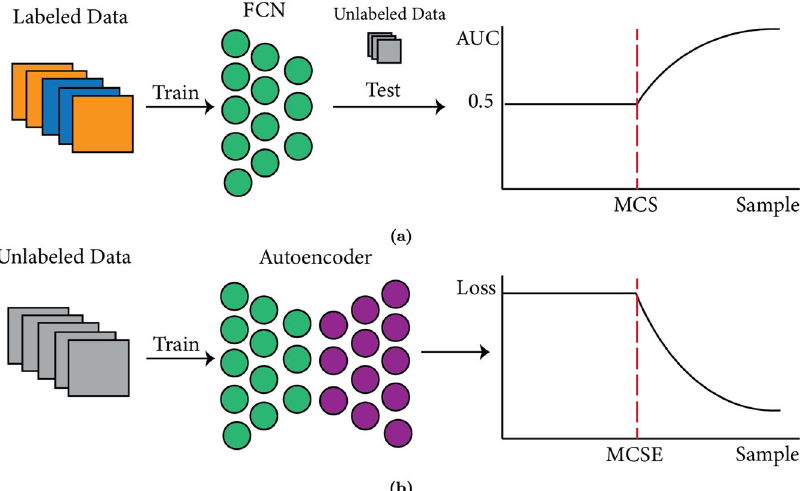
Fig. 1 Minimum convergence sample estimation can be used to approximate the number of labels required for generalizable performance. a A fully connected network is trained on labeled data, and tested on a unlabeled data. Generalizability Performance is measured via AUC. Minimum convergence sample (MCS) re fl ects the minimum number of labeled samples required for a fully connected network to start generalizing. b An autoencoder with a similar structure as the fully connected network is trained on unlabeled data and the